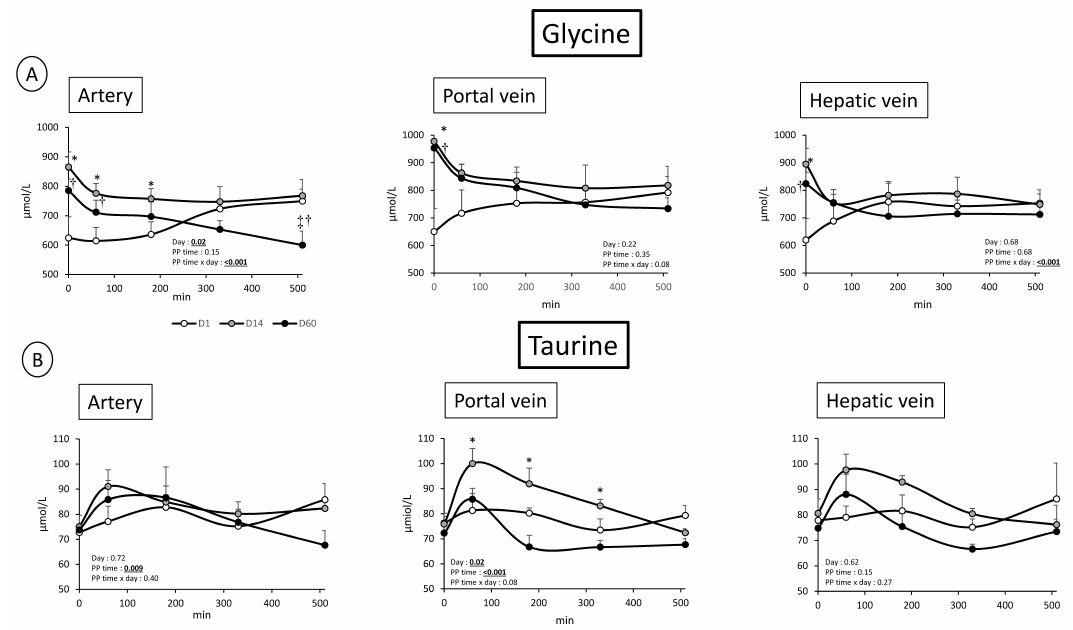
Figure 5. ( A ) Glycine concentration ( µ mol/L) after meal intake (Post prandial state, PP: 0 to 510 min) in artery, portal vein and hepatic vein; and ( B ) taurine concentration ( µ mol/L) after meal intake (post prandial state, PP: 0 to 510 min) in artery, portal vein and hepatic vein; before (D1) and after 14 days (D14) and 60 days (D60) of adaptation to HFHS diet. Two way RM ANOVA, * D14 significantly different from D1, † D60 significantly different from D1, ‡ D60 significantly different from D14; Values are means ± SEM. For calculations and statistical treatment of the data and for details, see Materials and